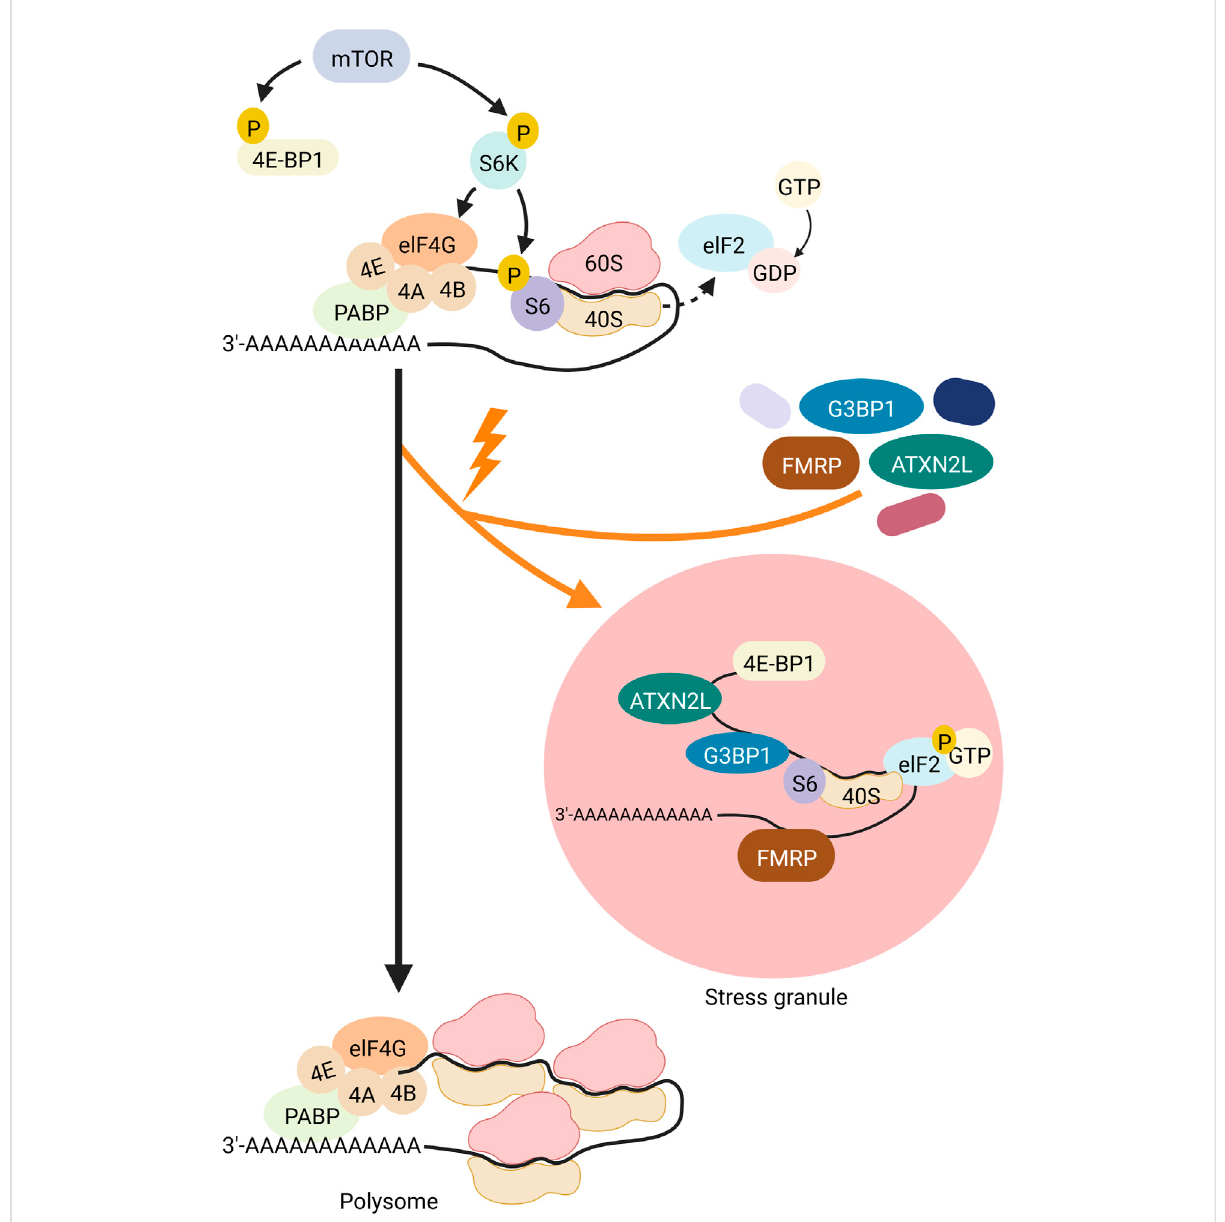
FIGURE 2 Schematic representation of translational induction and translational block via SG-formation. The kinase mTOR (gray) controls the phospho- dependentactivityofS6K(purple)and4E-BP1(yellow).4E-BP1isanegativeregulatoroftranslationthatrepressestranslationwhenattachedtothe5 ′ end of an mRNA. Its phosphorylation by mTOR leads to its detachment from the RNA and the release of this translational block. Simultaneously, S6K is phospho-activated by mTOR. Activated S6K phosphorylates its target S6 (purple), a ribosomal subunit. These two mTOR-dependent phosphorylation events promote assembly of the ribosome at the RNA and thus translation. Hydrolysis of GTP to GDP at the protein elF2 (light blue) releasesthebindingofelF2tothe40Ssubunitoftheribosome,allowingtheribosometoassembleandsubsequentlypolysomeformation.Uponcell stress (indicated by an orange fl ash), elF2 is phosphorylated, thus cannot detach from the 40S unit, thereby blocking translation and inducing polysome disassembly. Furthermore, 4E-BP1 is dephosphorylated and thus sticks to the 5 ′ end of the mRNA also inhibiting translation. In addition, proteins such as FMRP (brown), ATXN2L (green) and G3BP1 (dark blue) organize the stalled RNA into SGs. Created with